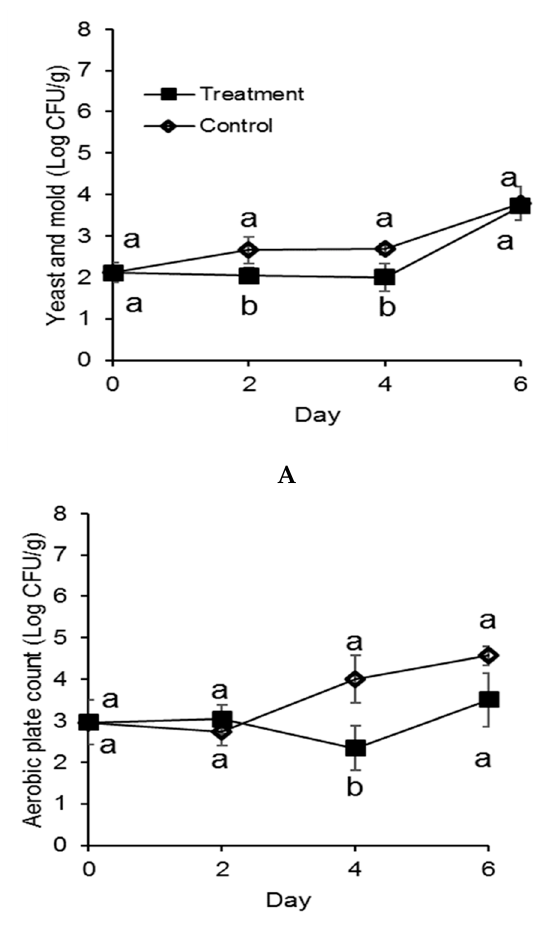
Figure 2. Yeast and mold count ( A ) and total aerobic plate count ( B ) of strawberries stored at 12 °C for 10 days in molded fiber baskets containing pullulan packaging films loaded with 1% w/w cinnamaldehyde SLN (treatment) or without (control). Different letters (a, b) for each day denotes a significant difference ( p < 0.05) between the treatment and the control. The error bars represent standard error.